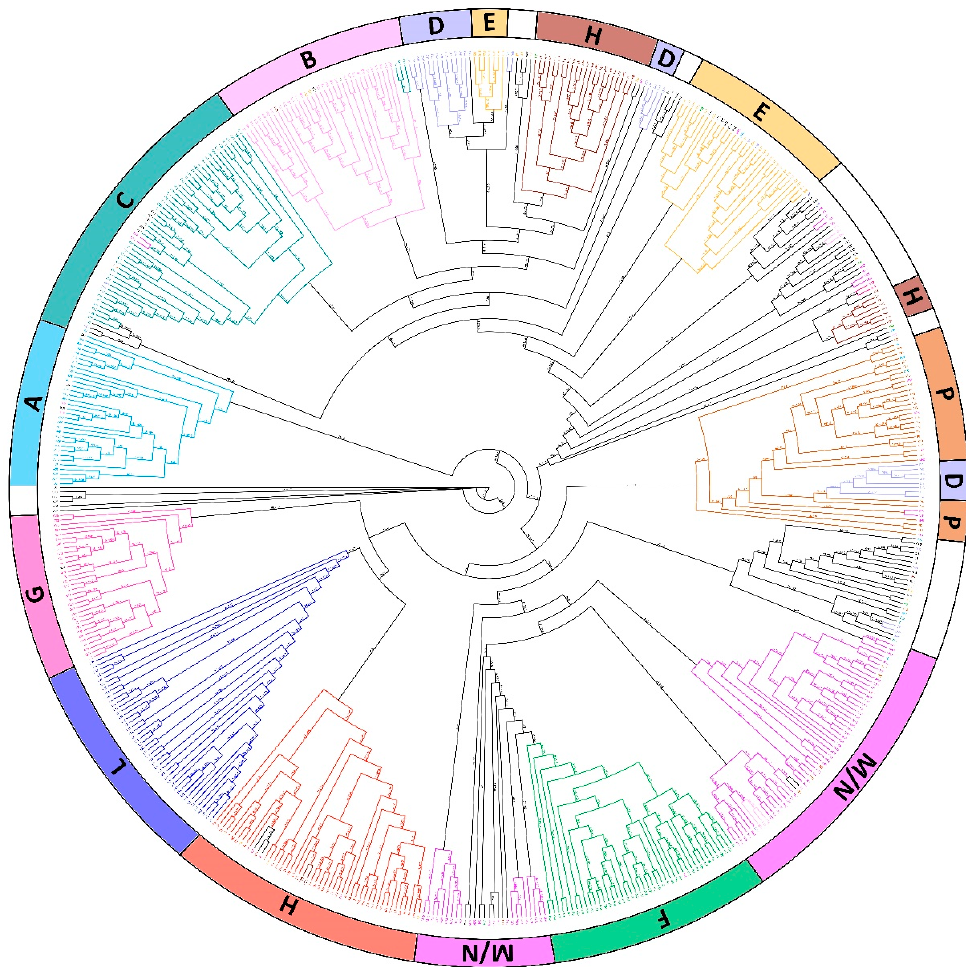
Figure 2. Maximum likelihood dendrogram topology portraying the genetic relationships among the different varieties identified by different colors and letters.